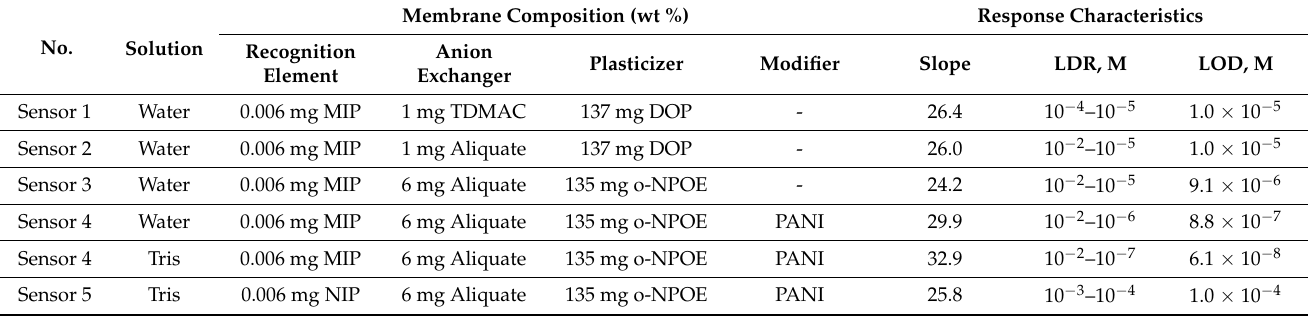
Table 2. Composition of the different SPEs and their response characteristics.